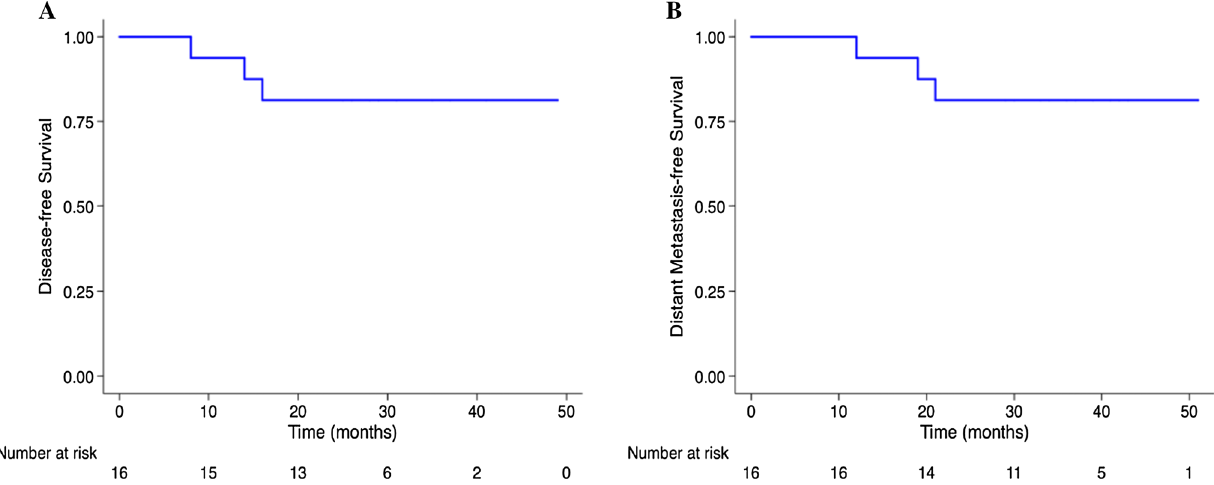
Fig. 1 Kaplan–Meier analysis curves of 16 patients who were diagnosed with LARC between January 2017 and December 2019, who had synchronous SILNM and no distant metastases, who underwent nCRT with ILN radiation boost prior to TME, some of who underwent ILN dissection, and some of who received ACT: A disease-free survival (DFS), and B distant metastasis-free survival (DMFS). The 3-year DFS and DMFS rates were both 81.3%. LARC, locally advanced rectal cancer; SILNM, solitary inguinal lymph node metastasis; nCRT, neoadjuvant chemoradiotherapy; TME, total mesorectal excision; ACT, adjuvant